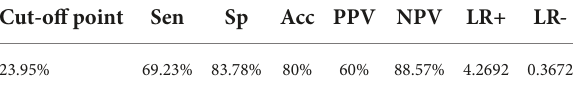
TABLE 4 Optimal cut-off point for diaphragm thickening fraction (DTF) with its corresponding sensitivity, specificity, and accuracy.